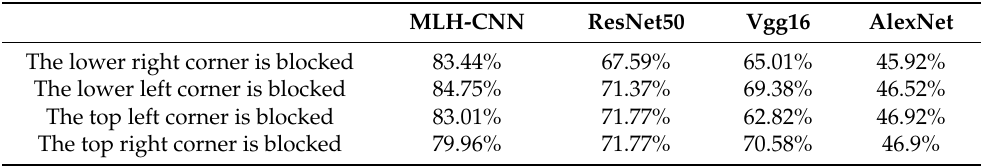
Table 5. Comparison of classification accuracy of different occlusion tests.